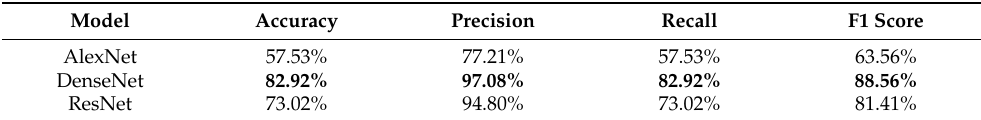
Table 4. Performance of three representative CNNs on the test set. The best metrics are highlighted in bold font in the table.